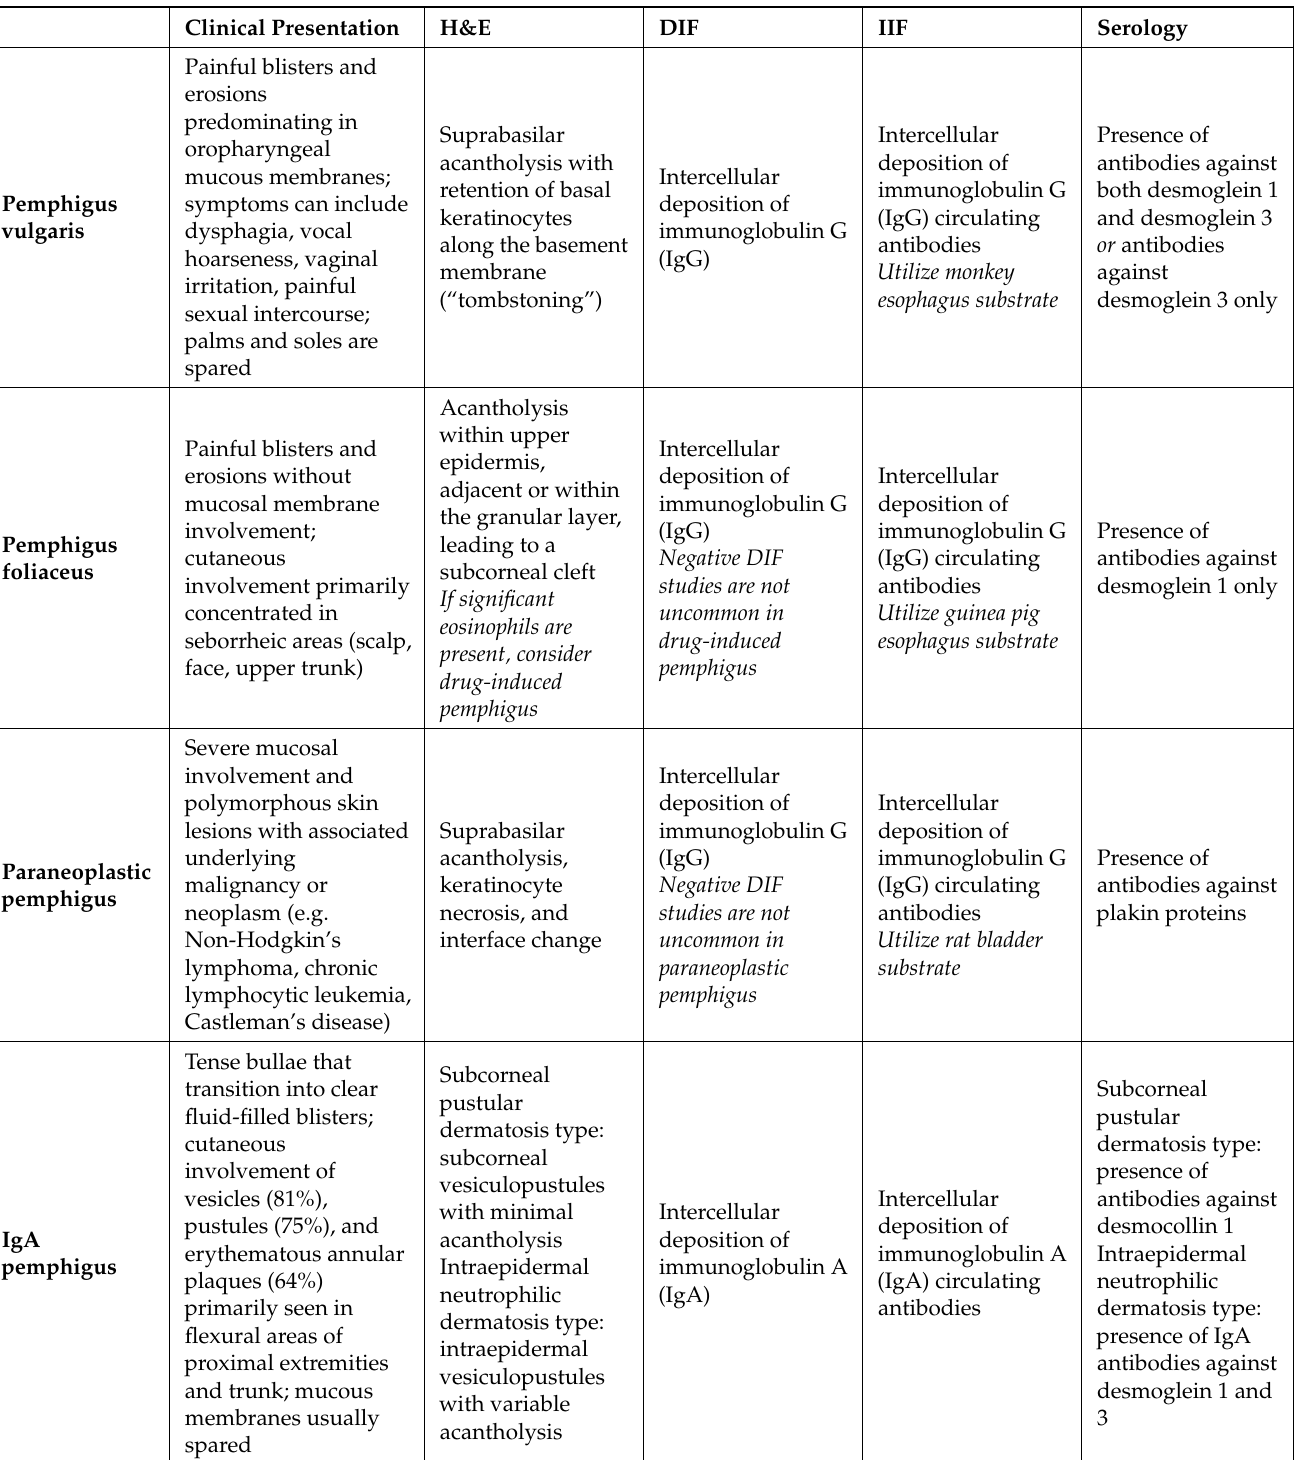
Table 1. Clinical diagnosis and laboratory work-up of pemphigus diseases; hematoxylin and eosin (H&E), direct immunoflu- orescence (DIF), indirect immunofluorescence